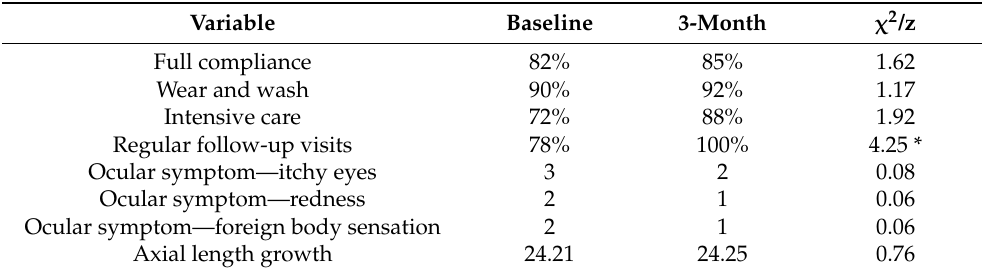
Table 7. McNemar test and Wilcoxon signed rank test of outcome